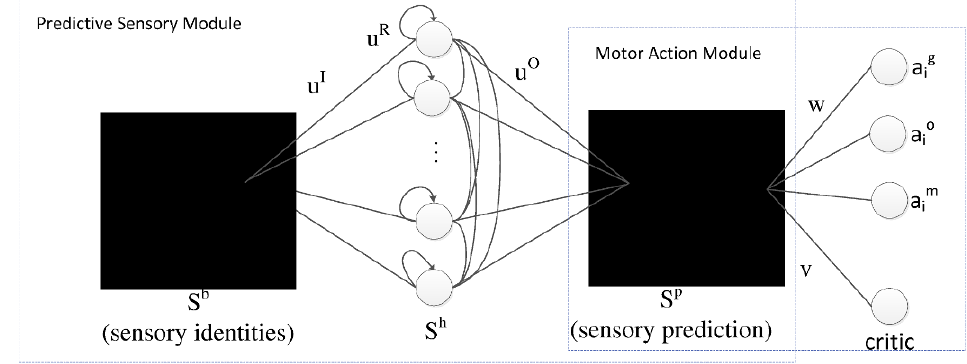
Figure 1. Overall architecture combining sensory prediction and sensorimotor action